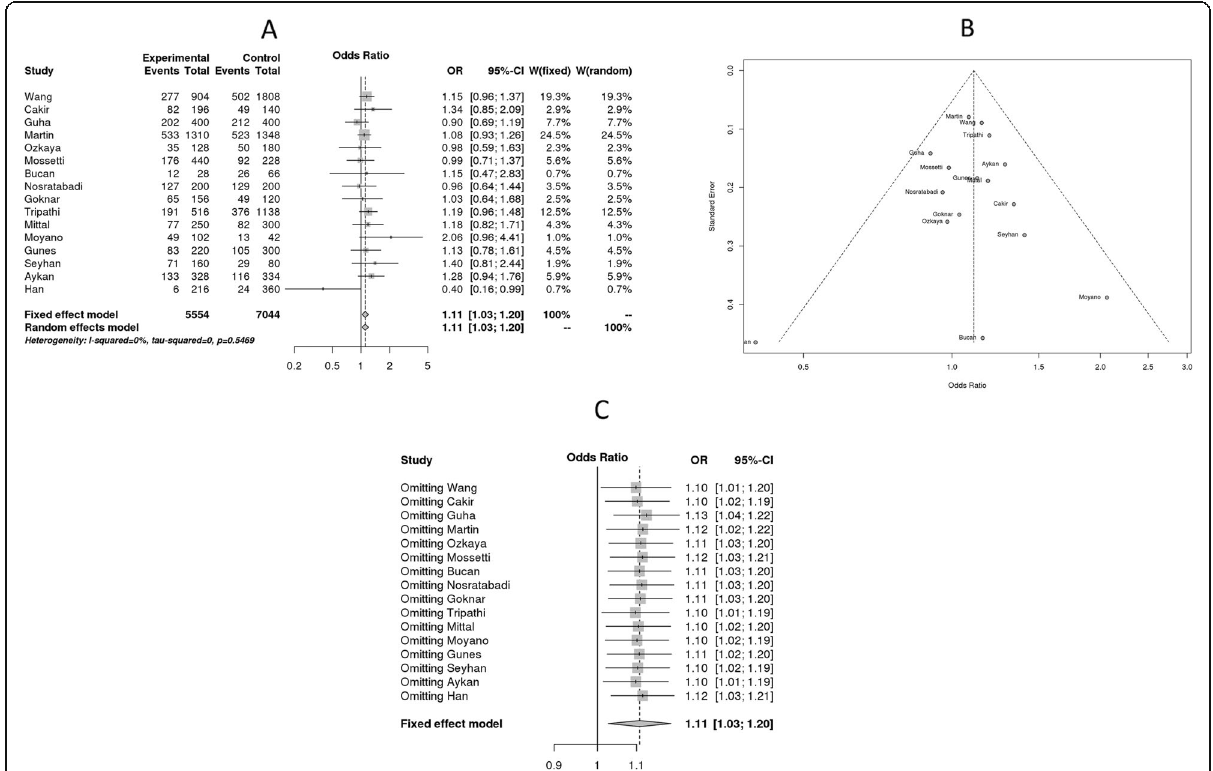
Fig. 2 Meta-analysis of association studies on VDR TaqI polymorphism vs. risk for renal disease. Forest plot: The terms experimental and control groups corresponds to cases and controls. Number of variant alleles was considered as events with respect to total number of alleles tested. This meta-analysis was based on 16 case-control studies representing seven population groups. VDR TaqI polymorphism was shown to exert risk for renal disease both in fixed effect and random effect models. Funnel Diagram: It is depicting that no heterogeneity in association. Sensitivity analysis: Exclusion of any of the study is not influencing the